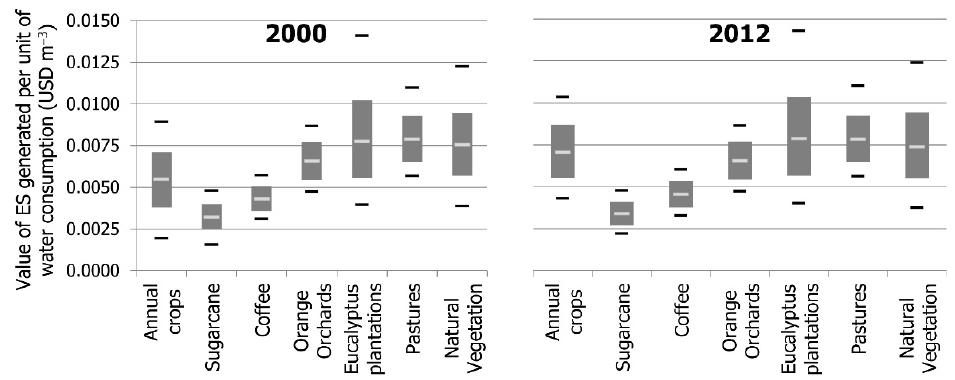
Figure 6. Box-and-whisker plots of ES value generated per unit of water (USD m − 3 ) per land use type for the years 2000 and 2012.